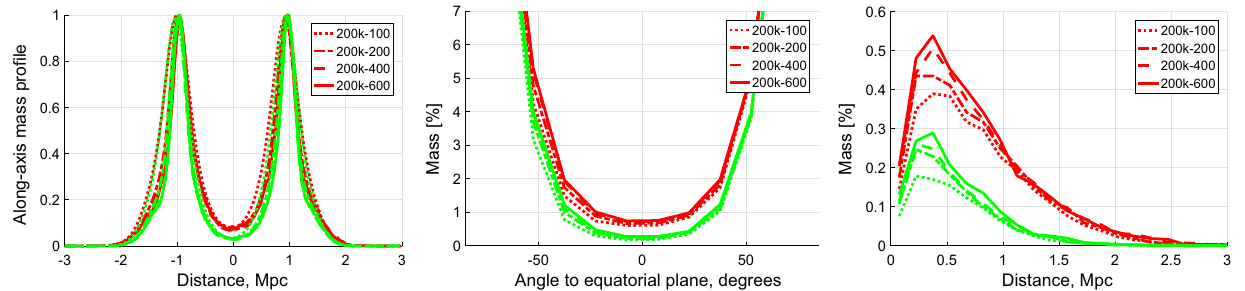
Red lines are for SIDM and green lines are for CDM simulations. The convergenceofthesimulationspastthegridsizesof D = 400 3 isclearly seen